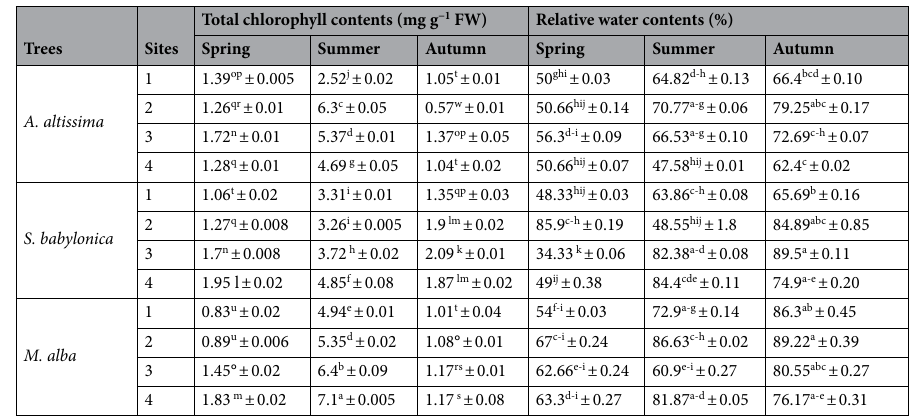
Table 1. Comparing the effect of air pollution stress on the total chlorophyll concentration (fresh weight, FW) and relative water contents of A. altissima , S. babylonica, and M. alba trees. Three seasons of Spring, Summer, and Autumn at Sites 1 (Mirdamad Street), 2 (Mirza Babaei Street), 3 (Kargar Shomali Street), and 4 (Azadi Bus Station Street) Tehran. The means that have at least one common letter did not show a statistically significant difference ( P < 0.05). Data are presented as mean ±